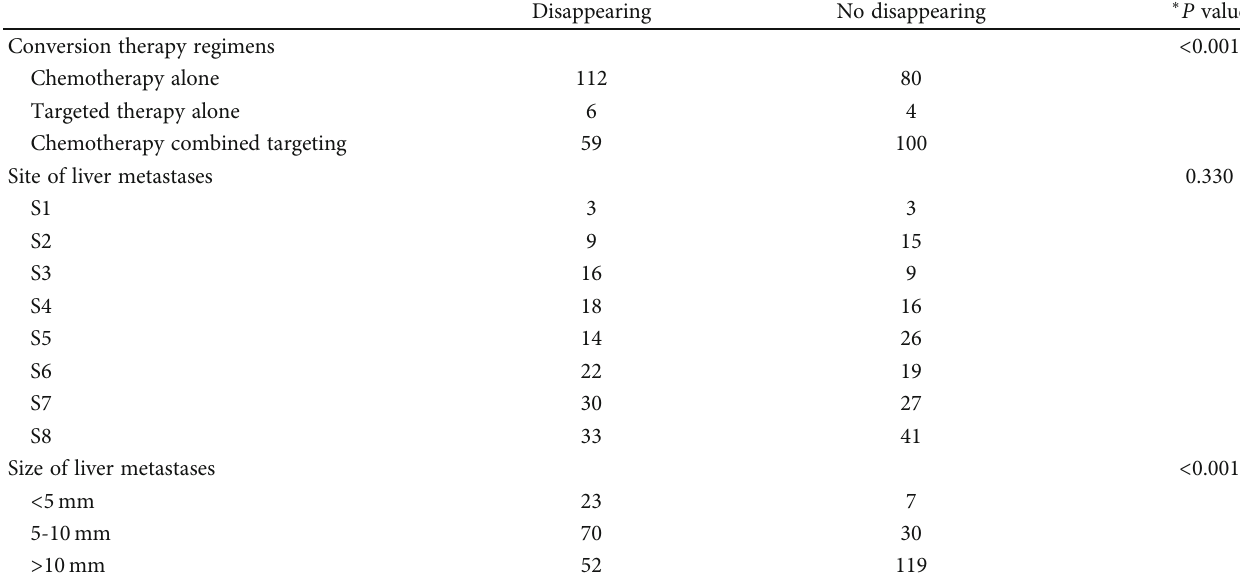
Table 3: The correlation of di ff erent factors and DLM.